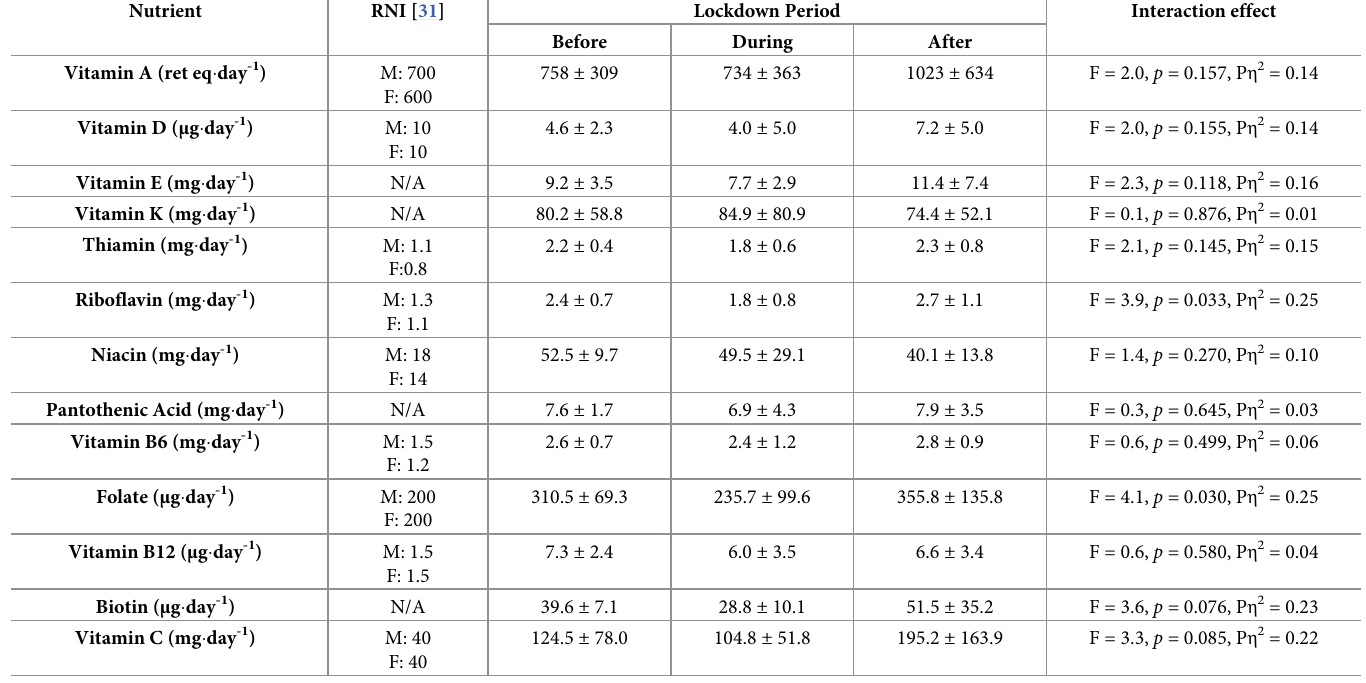
Table 5. Vitamin intakes recorded in the diets of highly trained adolescent swimmers before (January), during (April), and after (September) the 2020 COVID-19 lockdown. Nutrient RNI [31] Lockdown Period Before During